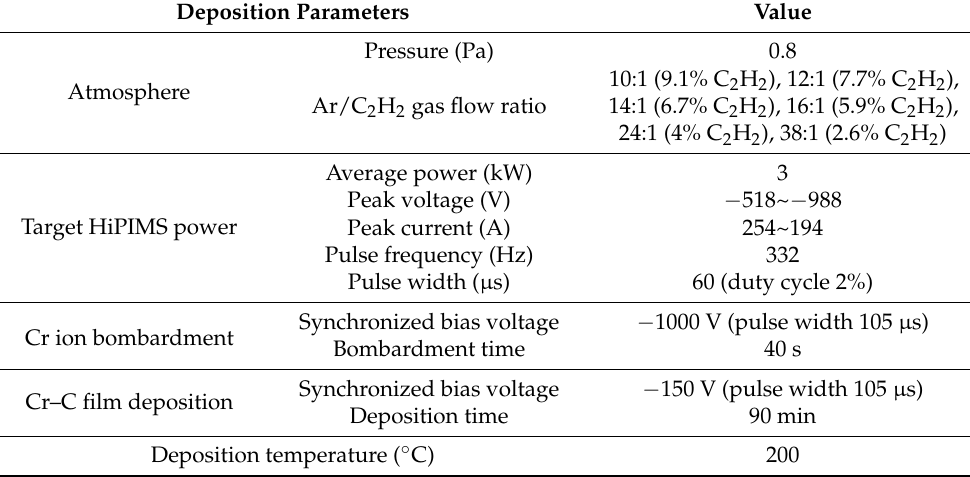
Table 1. Parameters for the deposition of chromium-carbon